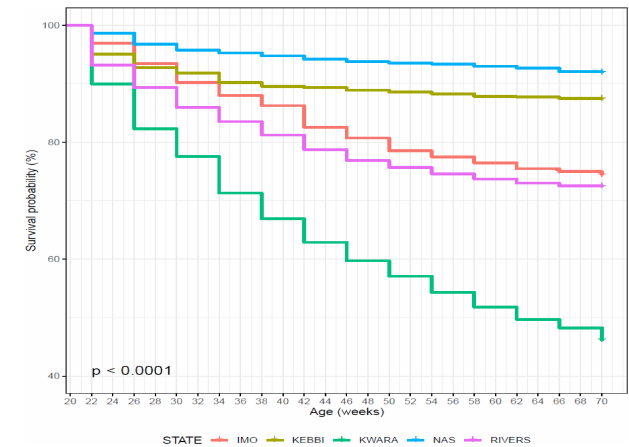
Figure 8. Effect of breed on survival performance of female birds raised on-farm in ACGG Nigeria project zones (20–72 weeks) (2016–2018).